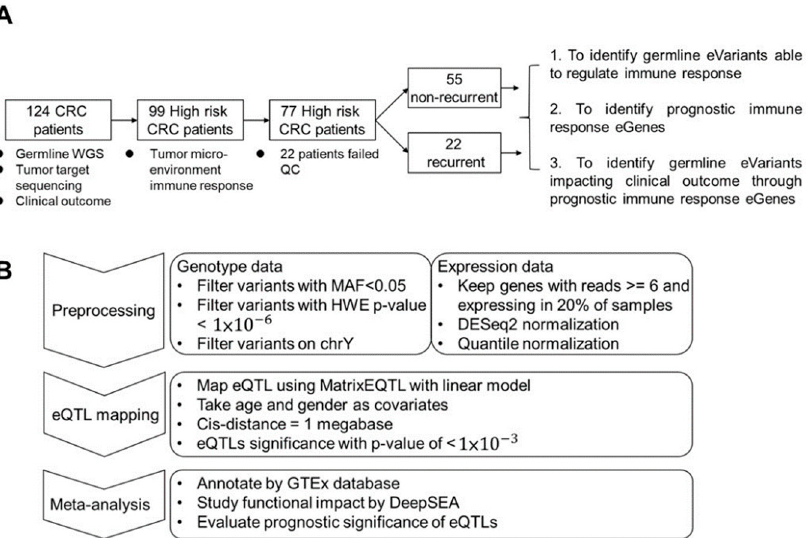
Figure 1. Study design and workflow for cis-eQTL mapping. ( A ) Study design. Overall, 126 CRC patients were enrolled in this study. Ninety-nine patients were subjected to RNA-seq analysis. After filtering low-quality data, 77 patients were kept for further study with three aims. The first was to identify cis-eQTL in patients’ tumor micro-environment. In the second, prognostic immune response genes were identified and used to cluster patients. Finally, eVariants that impacted patient survival through immune response eGenes were identified for further investigation. ( B ) Workflow of eQTL mapping. For the first step, variants derived from WGS with Hardy–Weinberg equilibrium p -values < 1 × 10 − 6 , a minor allele frequency among these patients of <0.05, or a location on non- autosomal chromosome or chromosome Y were excluded. Next, expression data were normalized via DESeq2 and quantile normalization. Next, the R package Matrix eQTL was used to map eQTL using age and sex as covariates, and the cis distance was set to 1 megabase (Mb). For the meta-analysis, known eQTL in the GTEx database, the functional impact predicted by DeepSEA, and prognostic significance were annotated to the resulting